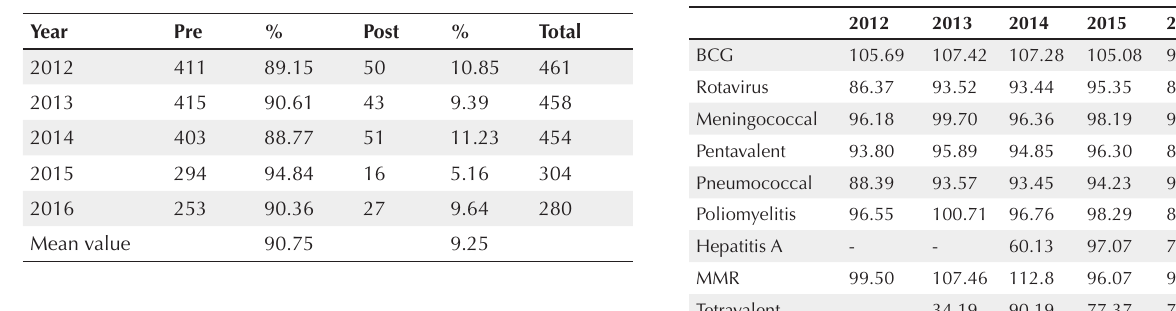
Table 2. Patients Attended in Pre- and Post-consultation - 2012/2016 Table 4. Vaccine Coverage (%) - Brazil – 2012/2016